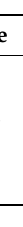
Table 3. Parameters of the proposed gate